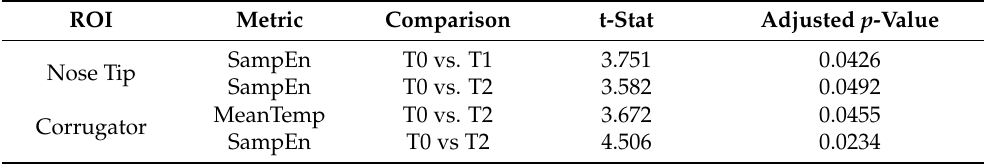
Table 2. Multiple comparisons (paired t -test) related to the RM-ANOVA. In the table, only significant comparisons are